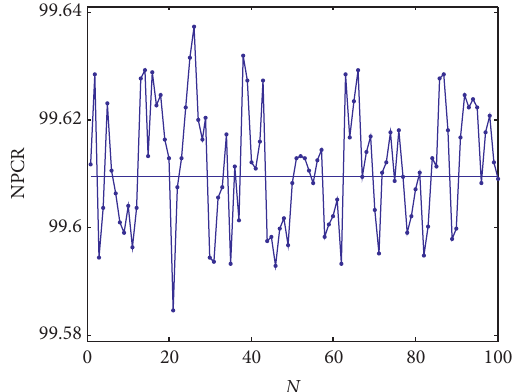
Figure 12: Test results of NPCR ( N is the test group label).